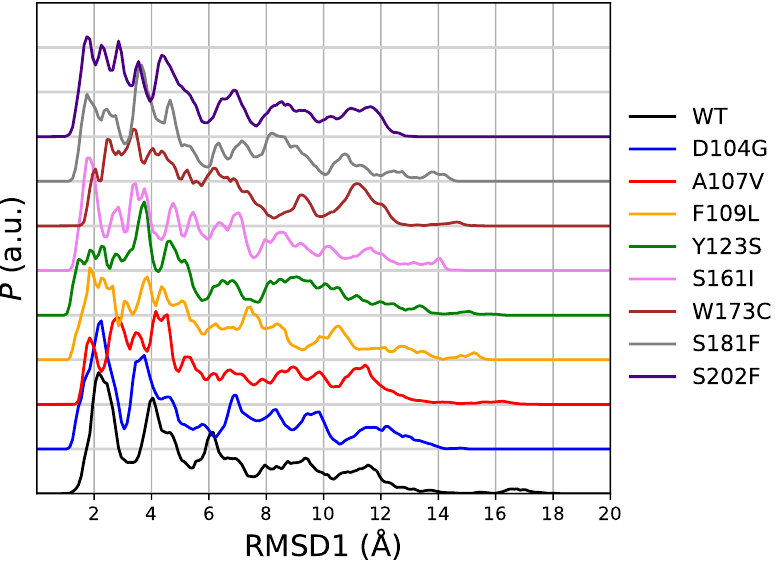
Figure 4. Distribution of root-mean square deviation with respect to PDB 1EKG (RMSD1) obtained in meta-statistics for all studied variants. The order is the same as for Figure